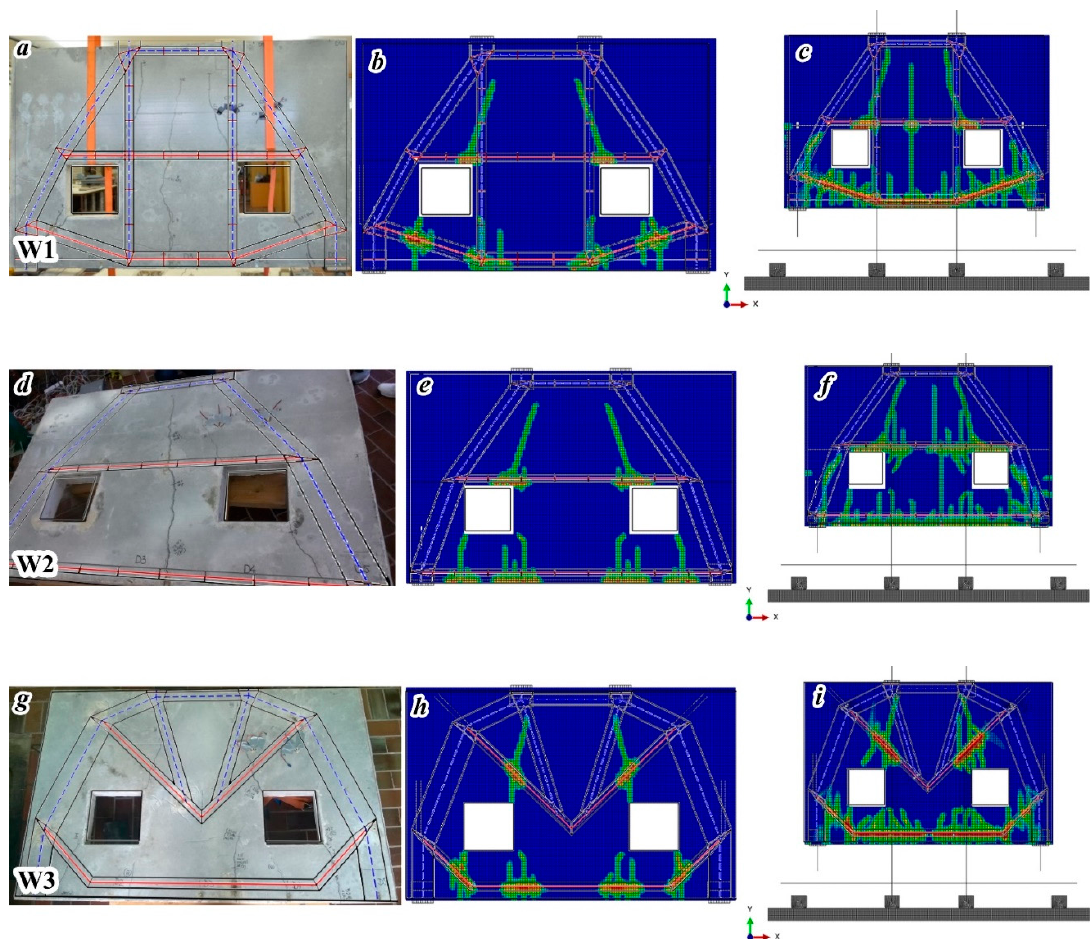
Figure 22. Shapes of the Strut-and-Tie models from “ST method” program for members W1, W2, and W3 and crack patterns obtained by: the experiment ( a , d , g ), model FEM A analysis ( b , e , h ), and model FEM B analysis ( c , f , i ).